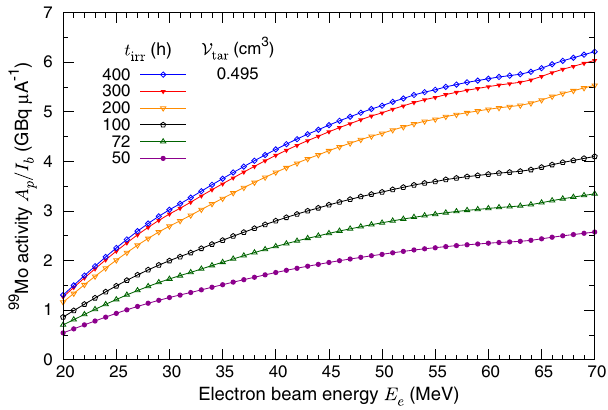
FIG. 4. 99 Mo activity calculated from Eq. (5) at different irradiation times, varying with electron beam